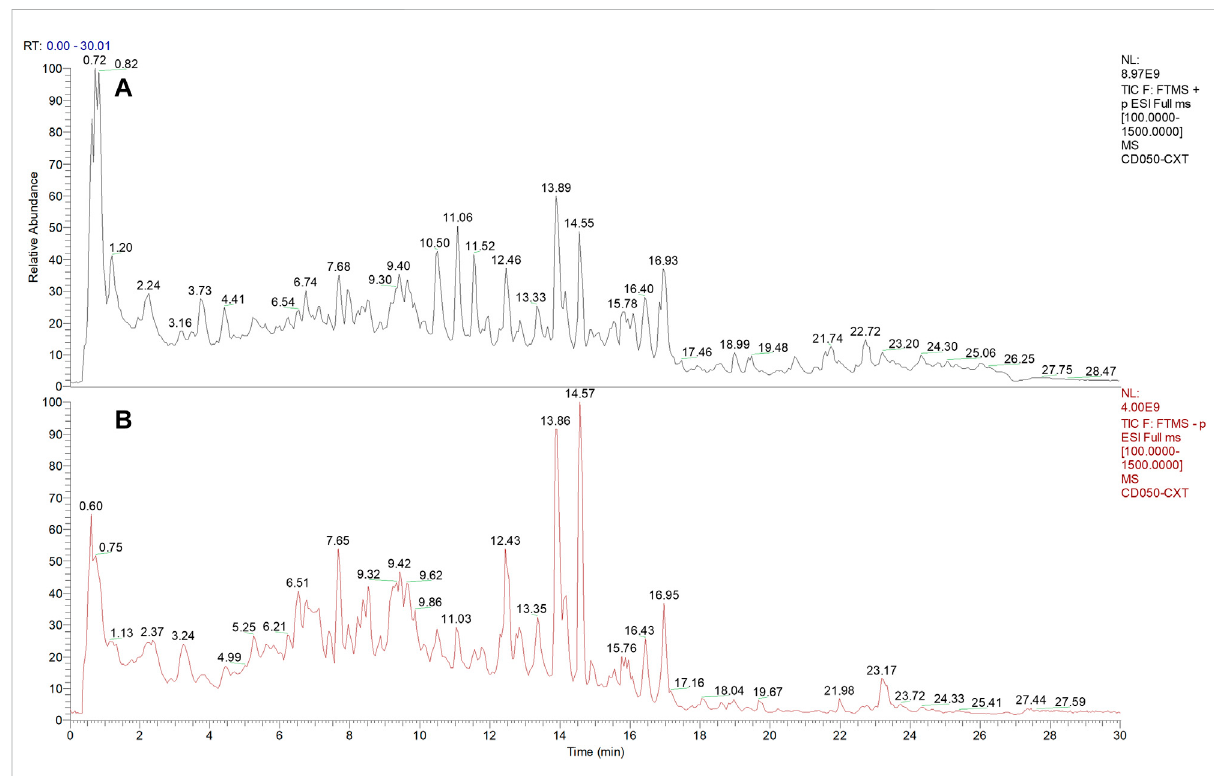
FIGURE 1 Chemical composition of AHWE. (A) Positive mode. (B) Negative mode.